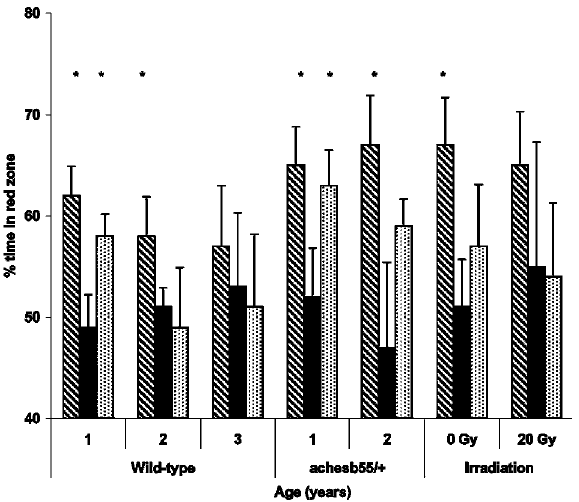
Figure 7. Change in place preference during and following Extinction. Percent time spent in the red half of the test tank 5 min prior to food administration on the last day of Conditioning (day 7, diagonal bar), same side of the tank on the last day of Extinction (day 11 in white- white test tank; black bar) and during post-extinction presentation of red color (day 12; dotted bar). Y-axis: % time spent in the red half of the tank (or corresponding half on day 11). X-axis – zebrafish age. * p , 0.05 relative to each group’s end of Extinction, day